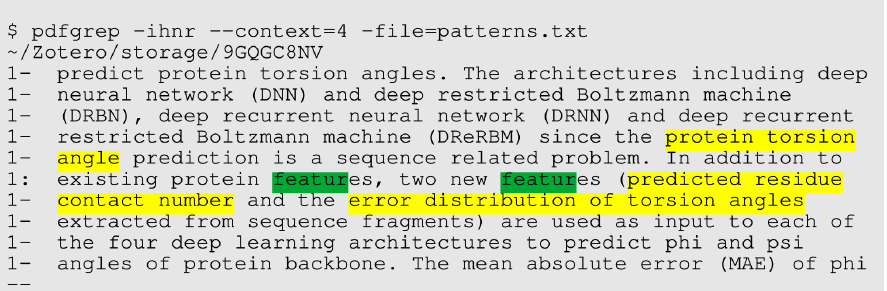
Figure 4. Example pdfgrep command and output for one publication. Features proximate to but not highlighted by the query are highlighted in